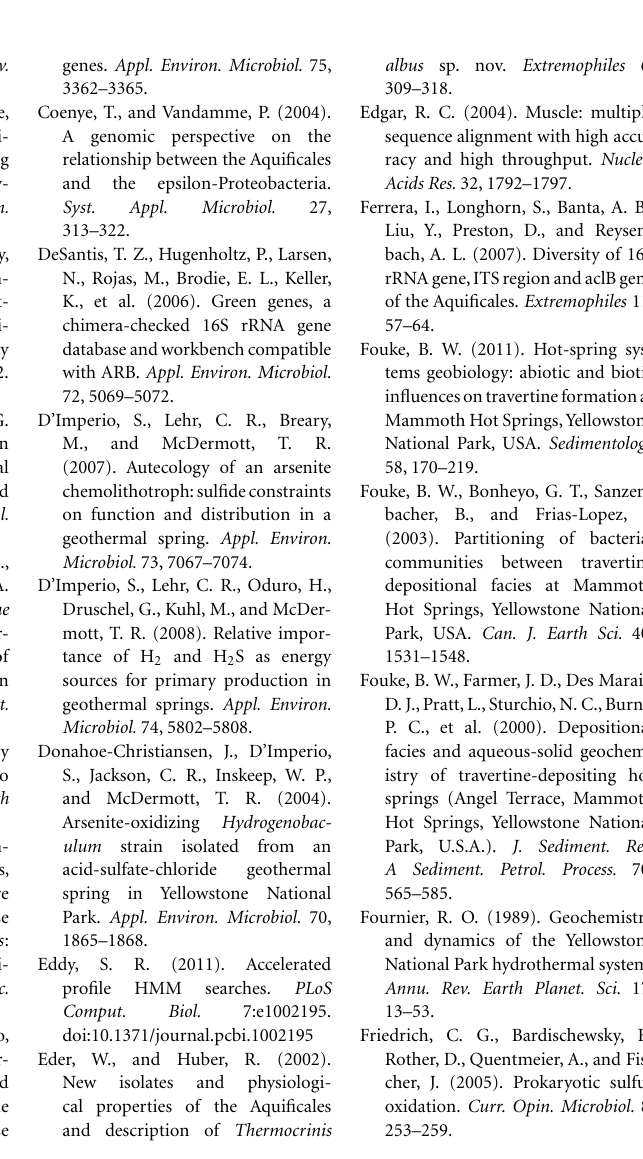
Table S1 | Number ofAquificales-like single-copy genes identified in assembled metagenome sequence usingAMPHORA (Wu and Eisen, 2008). Table S2 |TIGRFAM electron transport gene family counts across six Aquificales streamer communities and results for comparison of low-pH and high-pH sites usingWhite’s non-parametric T -test. Table S3 |TIGRFAM functional category gene family counts across six Aquificales streamer communities and results for comparison of taxonomically distinct sites (Hydrogenobaculum-dominated, Sulfurihydrogenibium-dominated,Thermocrinis (Aquificaceae)-dominated)